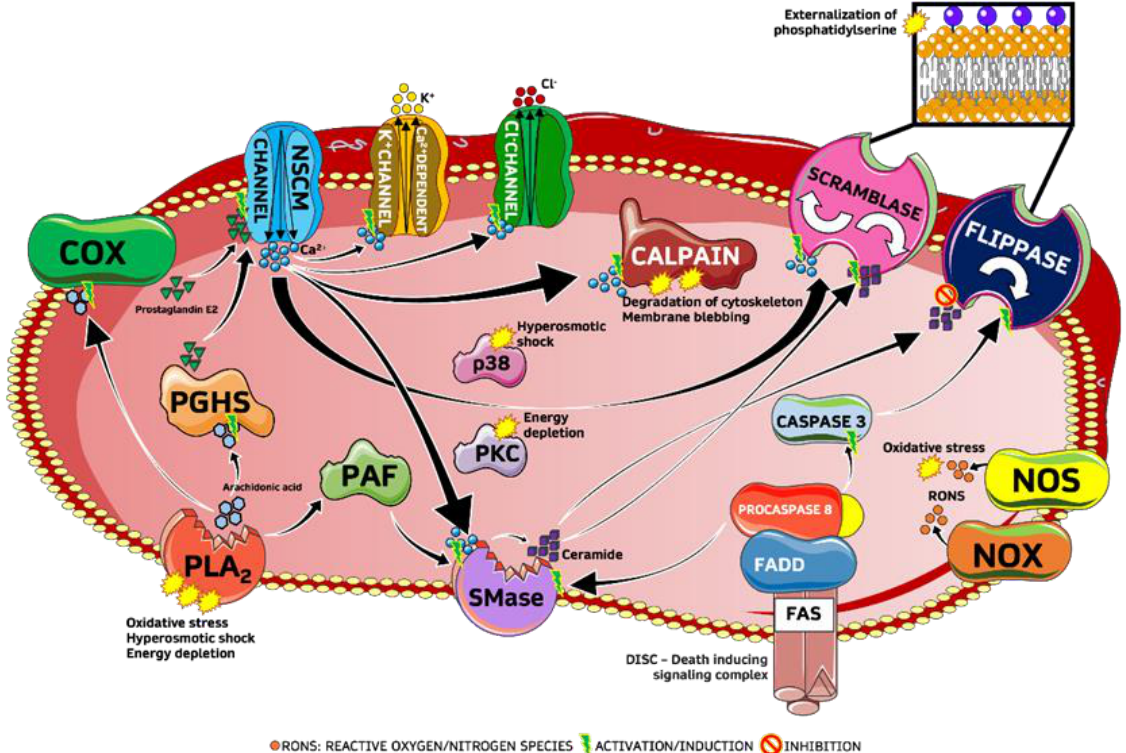
Figure 1. Synthetic scheme of eryptotic machinery. Sphingomyelinase (SMase), platelet-activating factor (PAF), phospholipase A 2 (PLA 2 ), prostaglandin endoperoxide synthase (PGHS), cyclooxygen- ase (COX), calcium sensitive non-selective (NSCM), protein kinase C (PKC), FAS-associated via death-domain (FADD), nitric oxide synthase (NOS), NADPH oxidase (NOX).